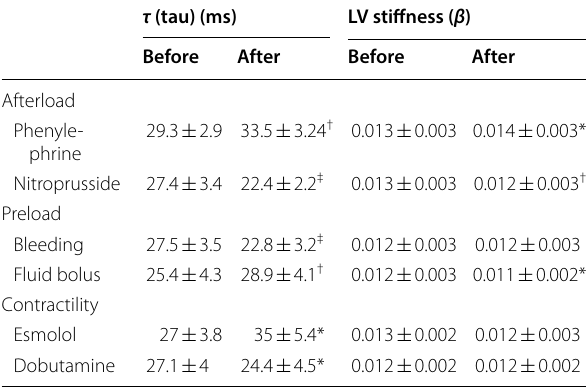
Table 2 Evolution of left ventricular diastolic function variables